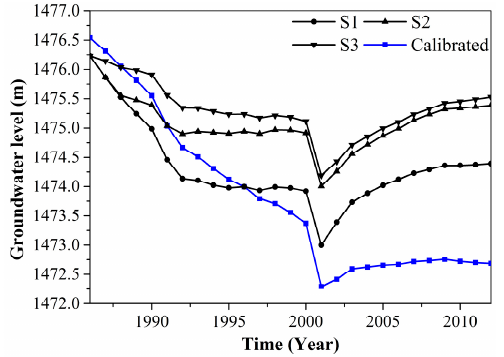
Figure 5. The optimized groundwater levels for S1, S2, and S3 and the base condition (the calibrated groundwater level) at the Daman observation well.